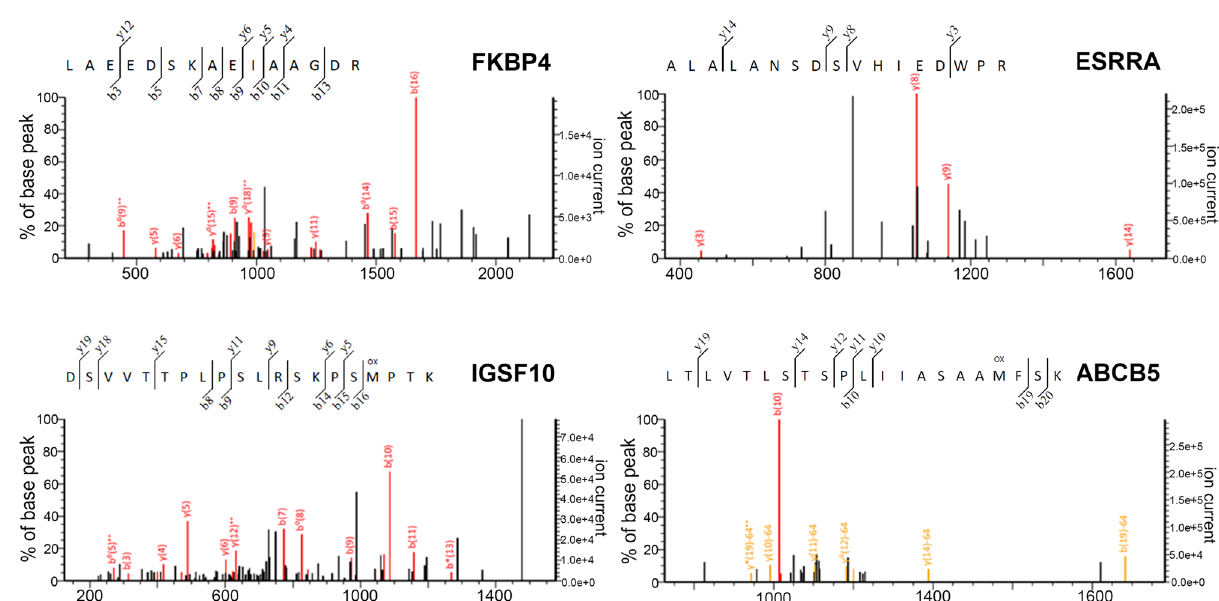
Figure 4. Analysis of four candidate peaks by LC-MS/MS. Peptidyl-prolyl cis-trans isomerase FKBP4 isoform X2 (FKBP4), steroid hormone receptor ERR1 (ESRRA), immunoglobulin superfamily member 10 (IGSF10) and ATP-binding cassette subfamily B member 5